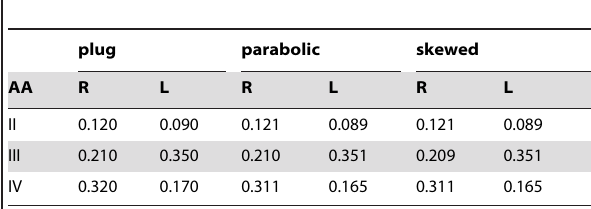
Table 2. Stage 21 3AA-cranial flow (mm 3 /s) distributions using a plug, parabolic, and skewed parabolic inlet